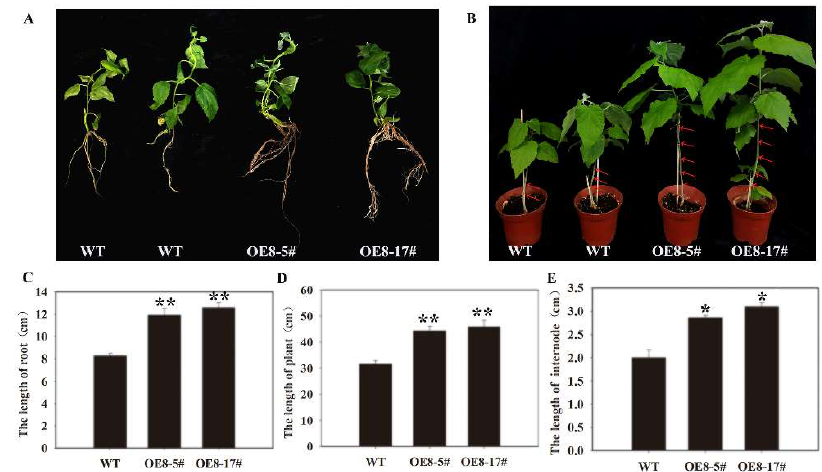
Figure 9. The phenotype analysis of PtoNF-YC8 transgenic P. tomentosa . ( A ) The phenotypic traits of PtoNF-YC8 transgenic P. tomentosa . ( B ) PtoNF-YC8 transgenic P. tomentosa plants with different growth phenotype. ( C ) Root length analysis. ( D ) Plant height analysis. ( E ) Internode statistical analysis. * ( p < 0.05) and ** ( p < 0.01) indicate significant differences. Figure B red arrows represent internodes.